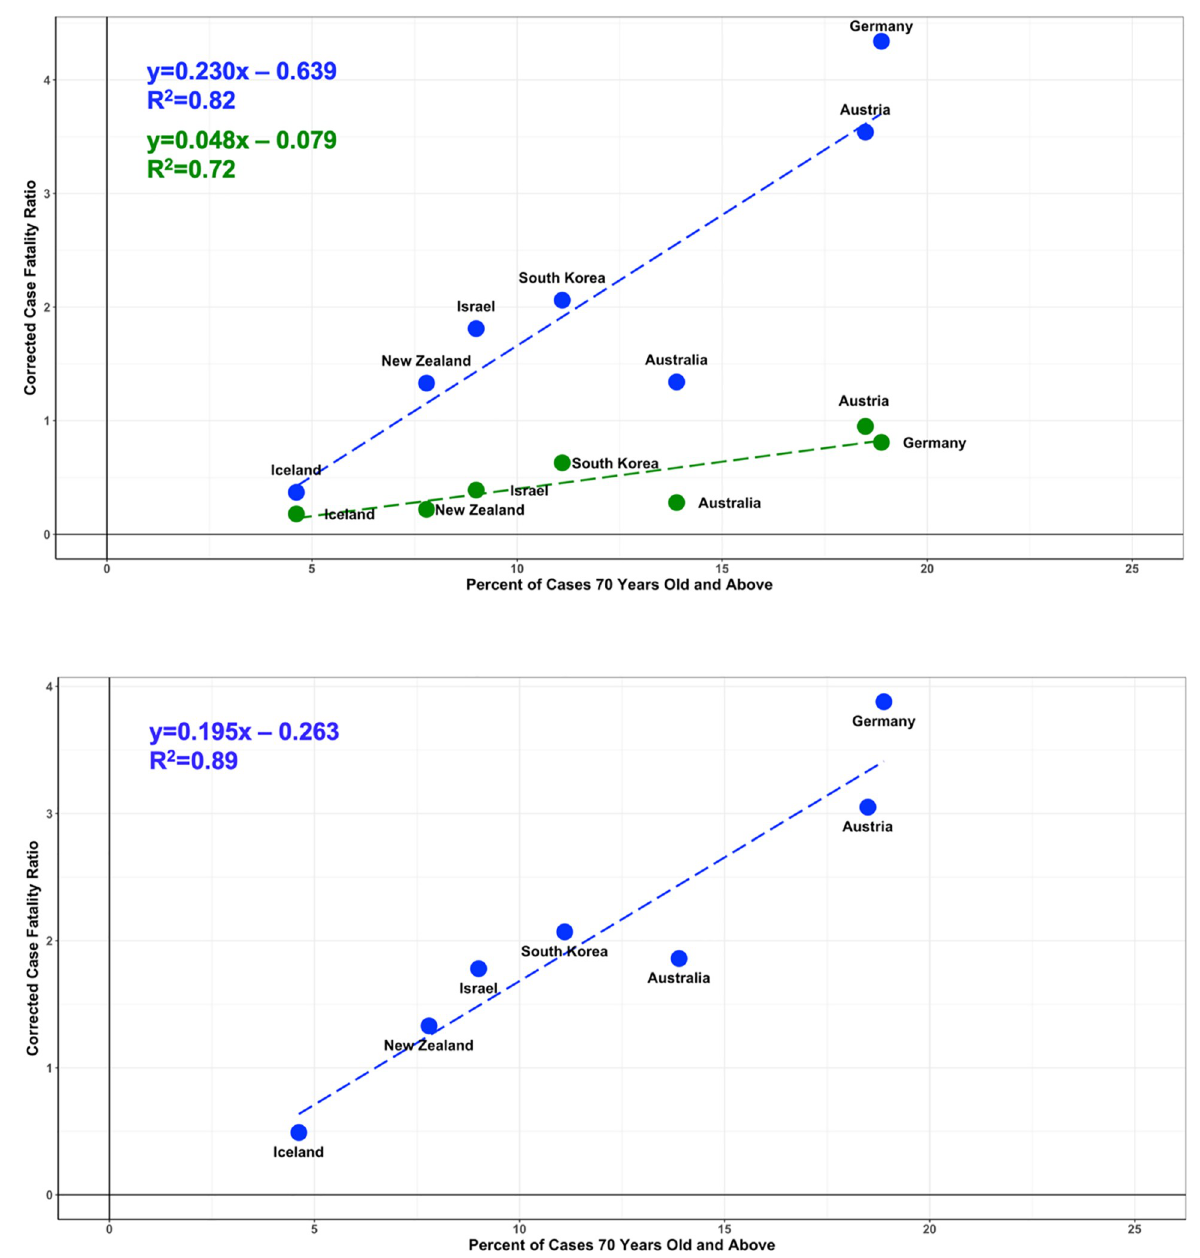
Fig 3. Linear regression analysis of CFR � crudetimecorrected(70+) , CFR � crudetimecorrected(70+)A , and CFR � crudetimecorrected(0 − 69) versus percent of cases 70 years old and above (p(70+)). A shows a plot of CFR � crudetimecorrected(70+) (blue) and CFR crudetimecorrected(0 − 69) (green) for each country versus the percent of cases 70 years old and above (p(70+)). It is seen that for all countries the CFR crudetimecorrected(70) term explains the large majority of CFR crudetimecorrected (81% +/- 8%). The majority of the variance in CFR crudetimecorrected(70) is explained by cases 70 years old and above (R 2 = 0.82). B shows a plot of CFR crudetimecorrected(70+A) (blue) for each country. The value of cCFR 70+A for each country was calculated by adjusting the fraction of cases in the 70 and over group who are 80 years old and above to be 40% (p(80+)/p(70+) = 0.40), which is the mean of the countries examined (Table 3). The higher fraction of the variance explained by age for CFR crudetimecorrected(70+A) (R 2 = 0.89) indicates that the percentage of the population 80 years and older are an important factor in determining the average population value of CFR crude .